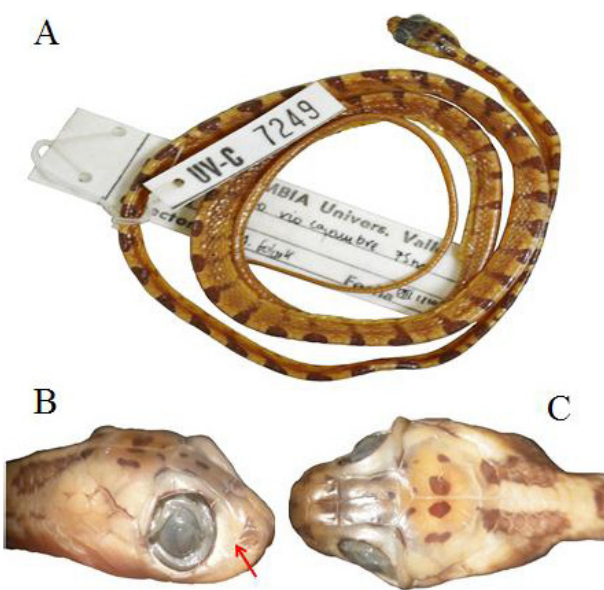
Figure 2. Specimen from La Quebrada El Caimancito, Cajambre River, Buenaventura, Valle del Cauca, 3°28’24.85” N, 77°11’9.82” W, 75 m (UVC- 7249): A) pattern of dorsal spots; B) lateral view of head, indicating the absence of the loreal scale, C) dorsal view of